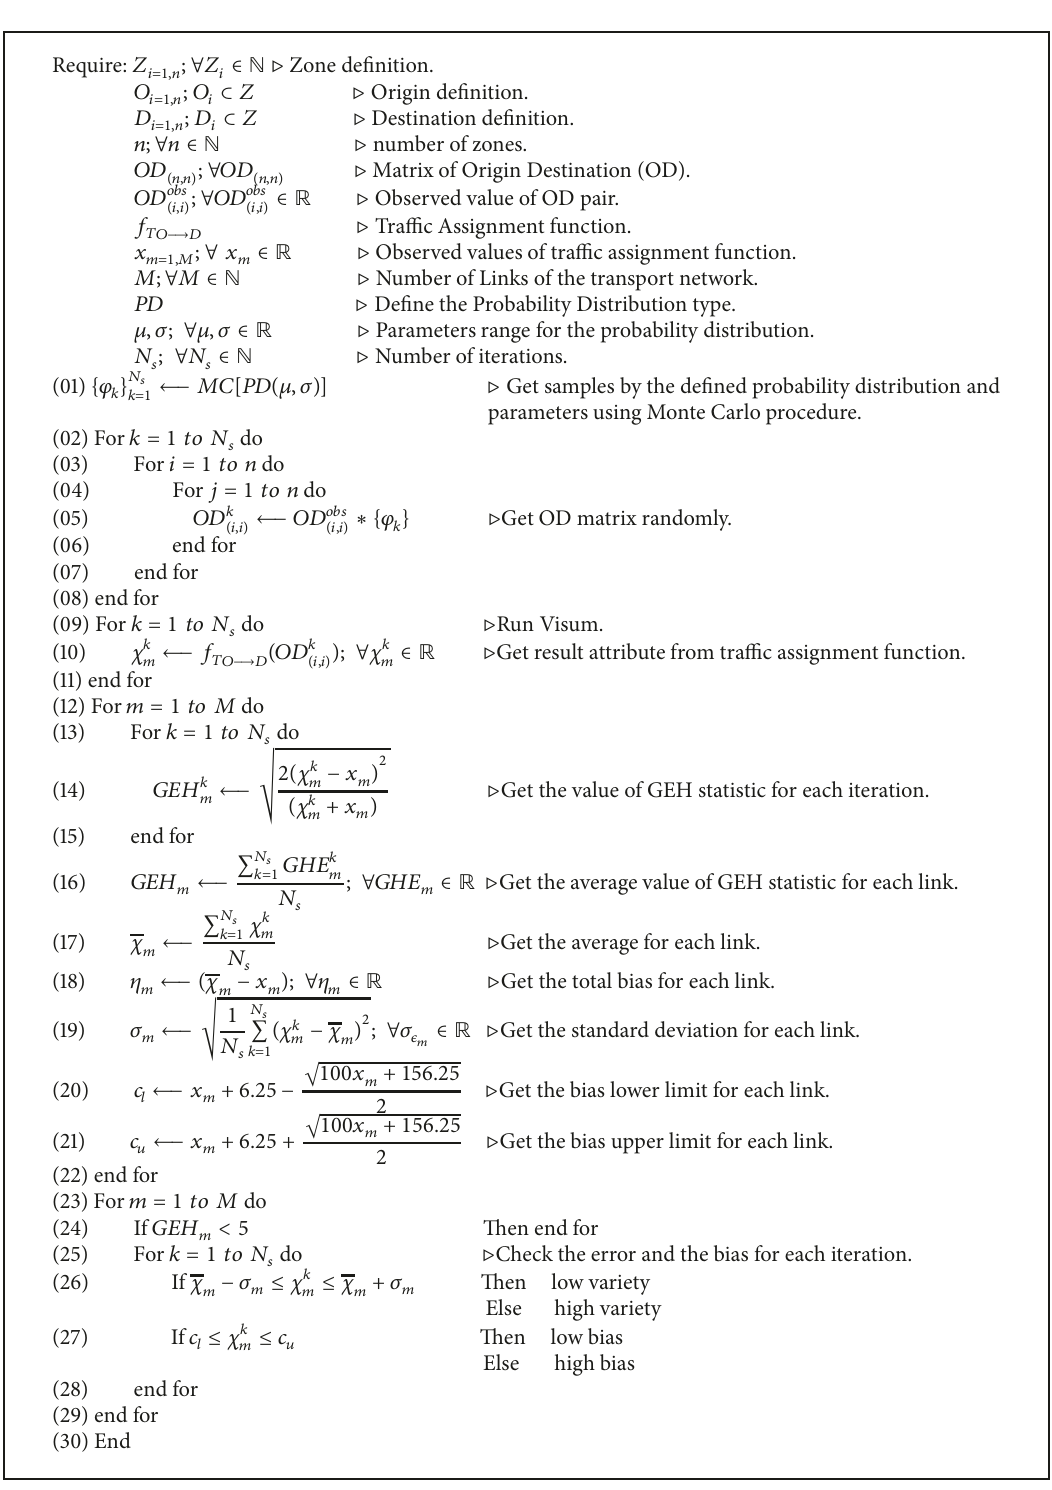
Algorithm 1: Prediction of uncertainty in traffic assignment using Monte Carlo